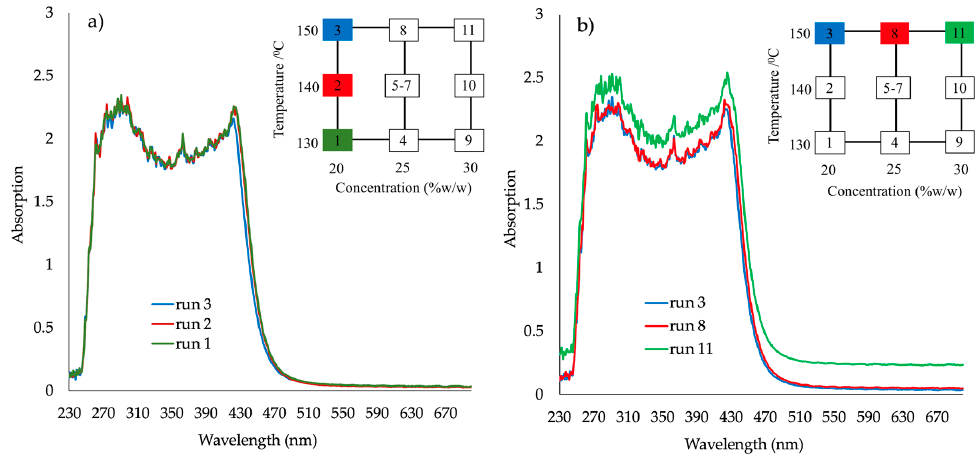
Figure 6. Absorbance spectra for the response surface design runs (DoE2) ( a ) API 20% w / w at 130 °C (run 1) 140 °C (run 2) and 150 °C (run 3); ( b ) temperature at 150 °C for API concentrations 20% w/w (run 3), 25% w / w (run 8) and 30% w / w (run 11).